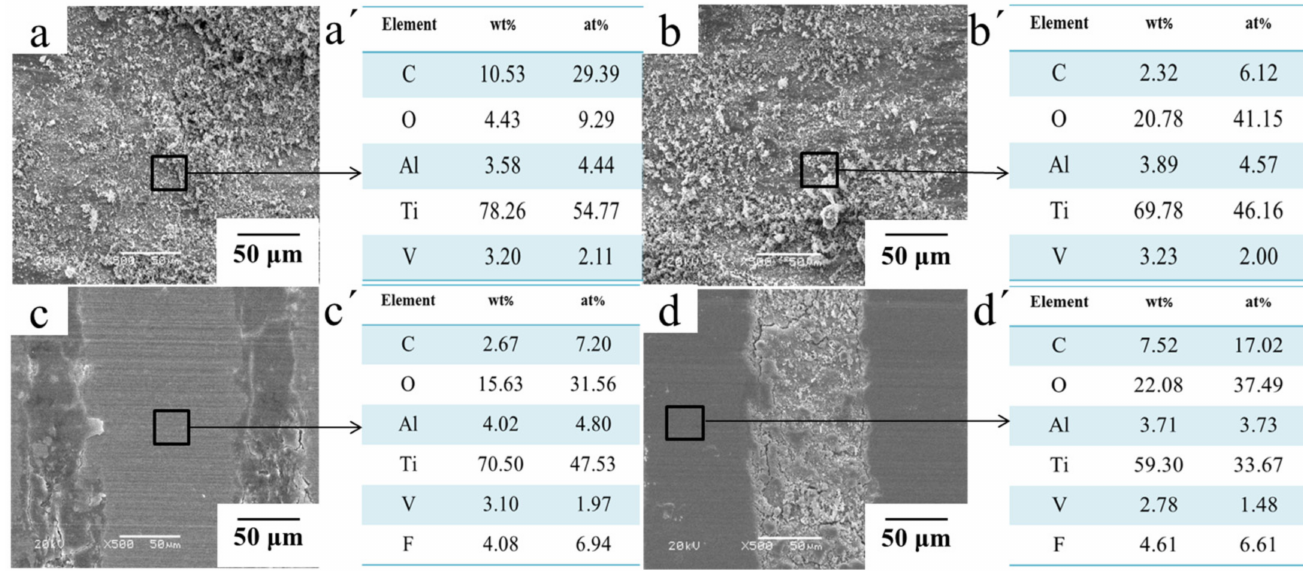
Figure 10. EDS contents of the worn surfaces of untextured surface ( a , a’ ), TO surface ( b , b’ ), textured surface ( c , c’ ), and TO+ textured surface ( d , d’